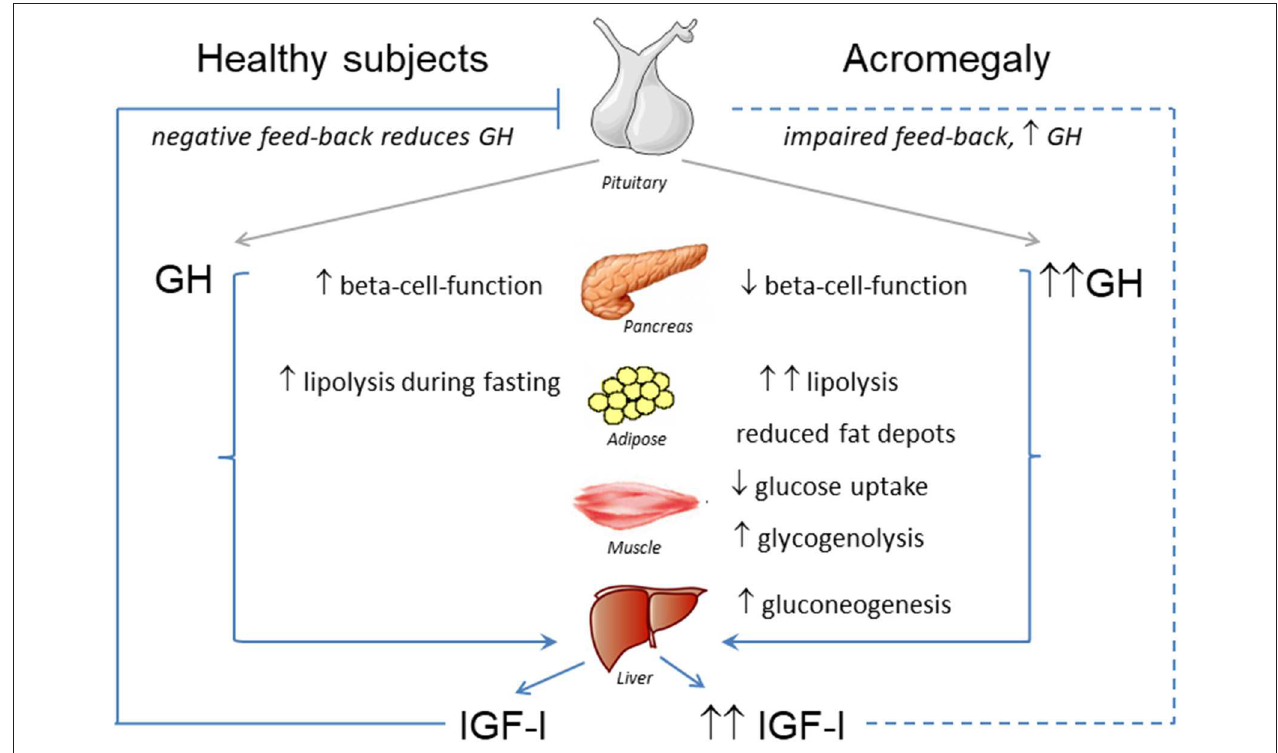
FIGURE 1 | Effects of GH-IGF-I hypersecretion in metabolic